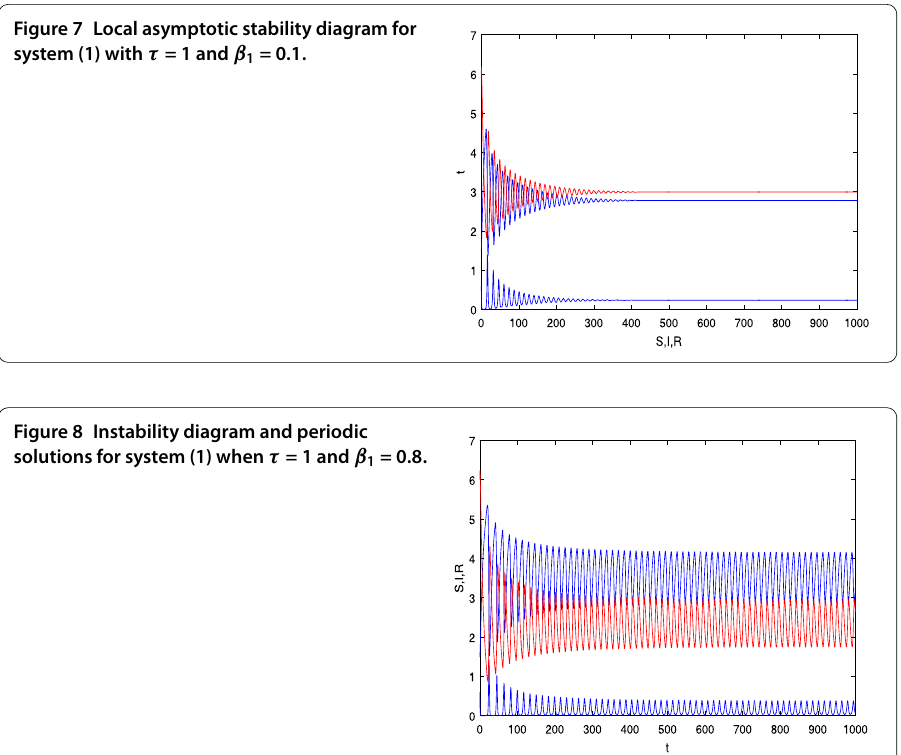
Figure 7 Local asymptotic stability diagram for system (1) with τ = 1 and β 1 = 0.1.